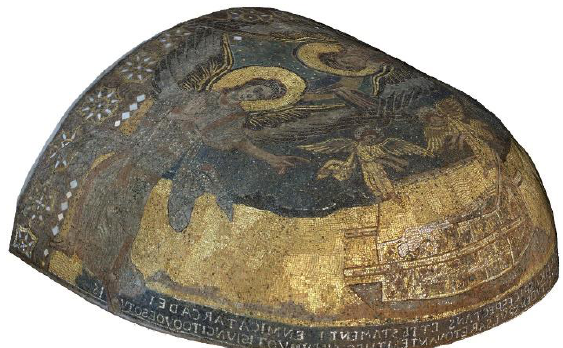
Figure 5 photogrammetric point cloud, unrealistic view from